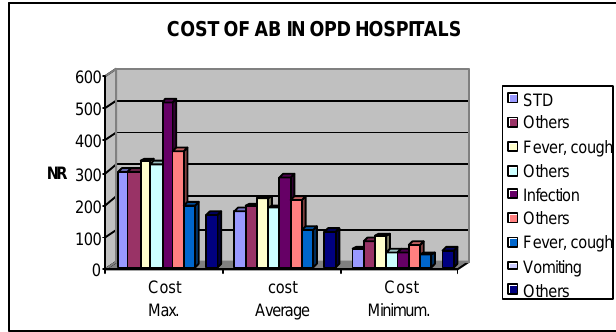
Fig. 5a : Showing pharmaco-economics of antibiotics treatment in all health problems in Hospitals OPD (cost in Nepali Rupees)